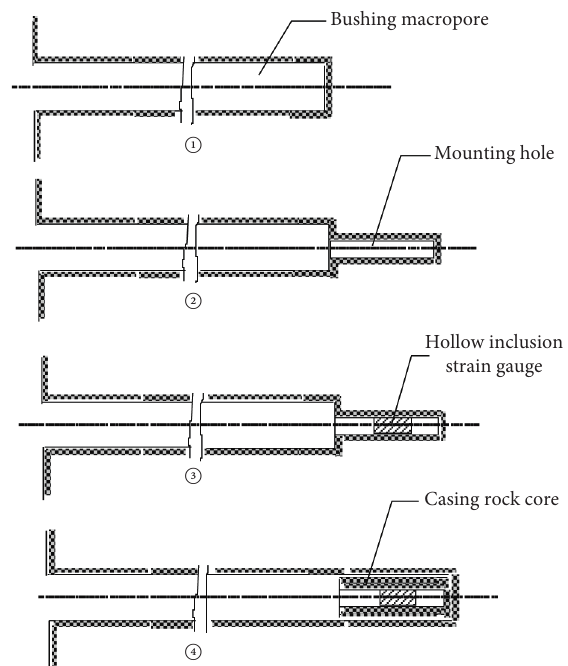
Figure 2: Schematic diagram of measurement steps of the stress relief